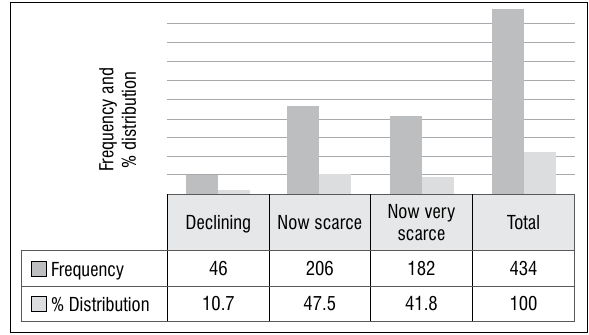
Figure 7: Local community perceptions of the state of forest food resources ( n